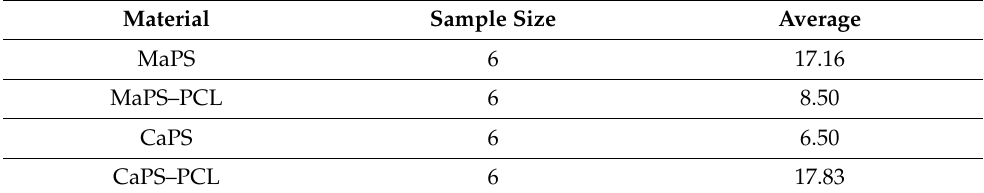
Table 5. Kruskal–Wallis test for the tensile strength of the